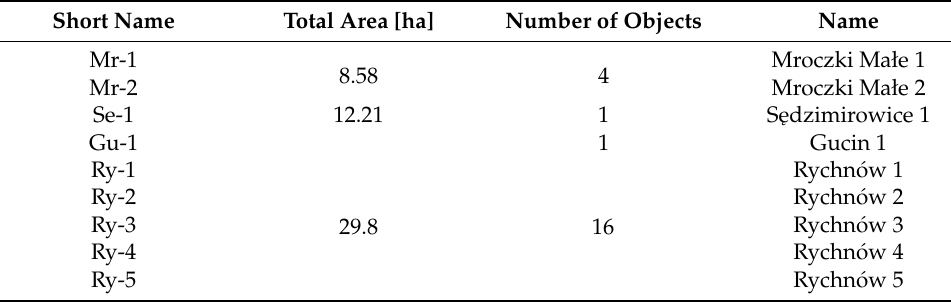
Table 5. Locations of the selected greenhouse